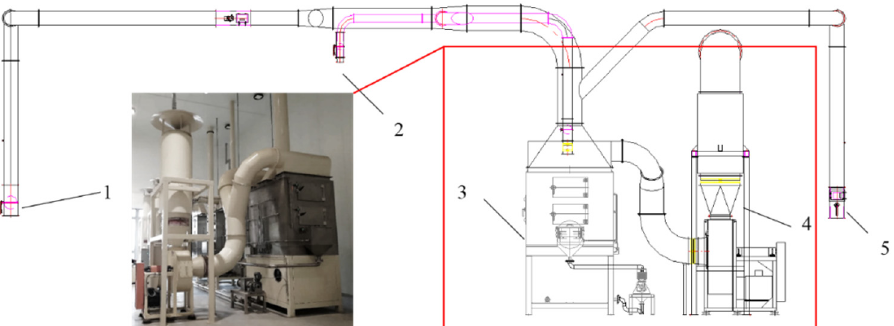
Figure 2. Self-excited dust collector in the stem feeding tobacco workshop (1-air inlet of the tobacco stem feeder; 2-air inlet at the stem-soaking machine; 3-self-excited dust collector; 4-centrifugal fac; 5-air inlet for moisture removal of the stem-soaking machine).